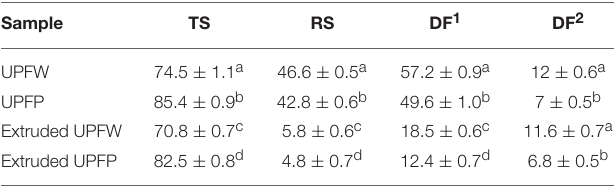
TABLE 2 | Total starch (TS), resistant starch (RS), and dietary fiber (DF) content in native and extruded flours of unripe plantain pulp (UPFP) and whole fruit (UPFW) (g/100g).